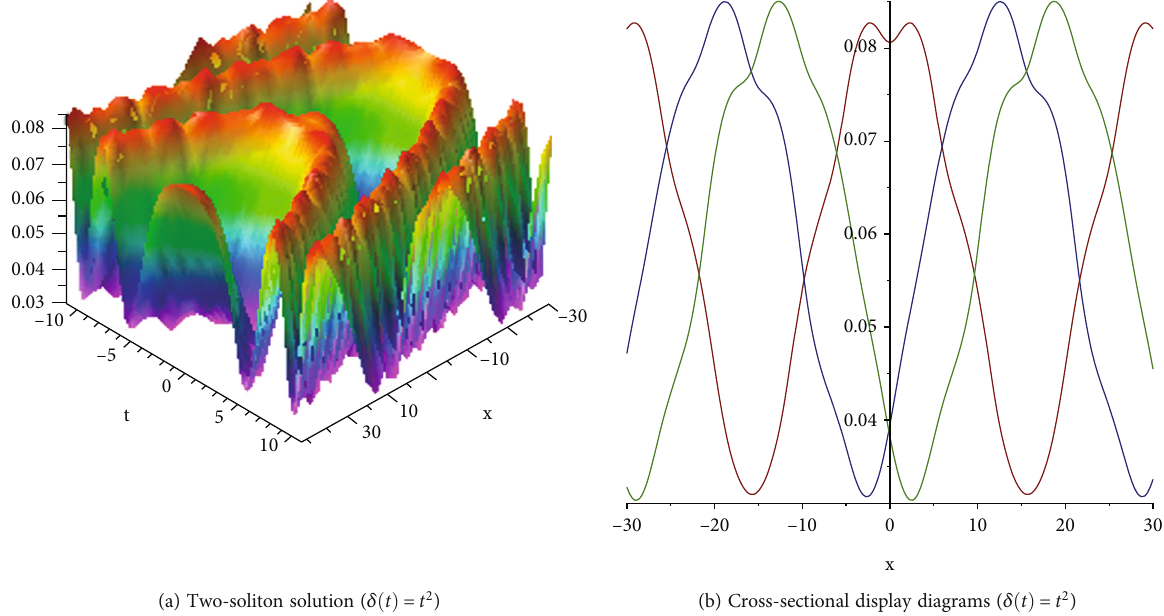
= 0 : 4 i , k = 0 : 6 i . (b) Cross-sectional shots of solution (a) at t = 0 1 2